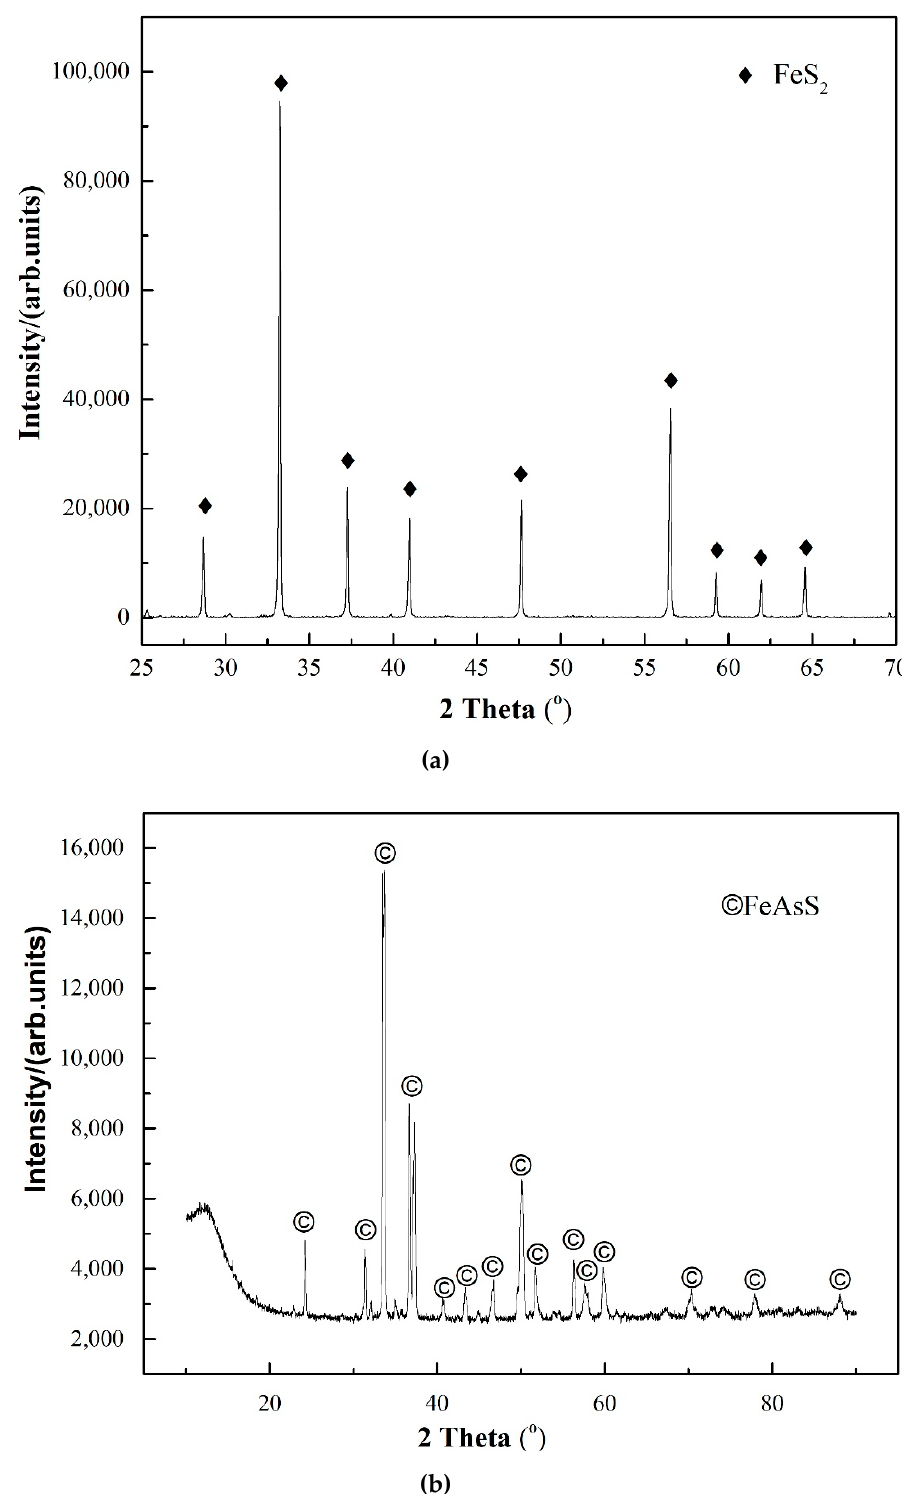
Figure 1. X-ray diffraction (XRD) patterns of pyrite ( a ) and arsenopyrite ( b ).